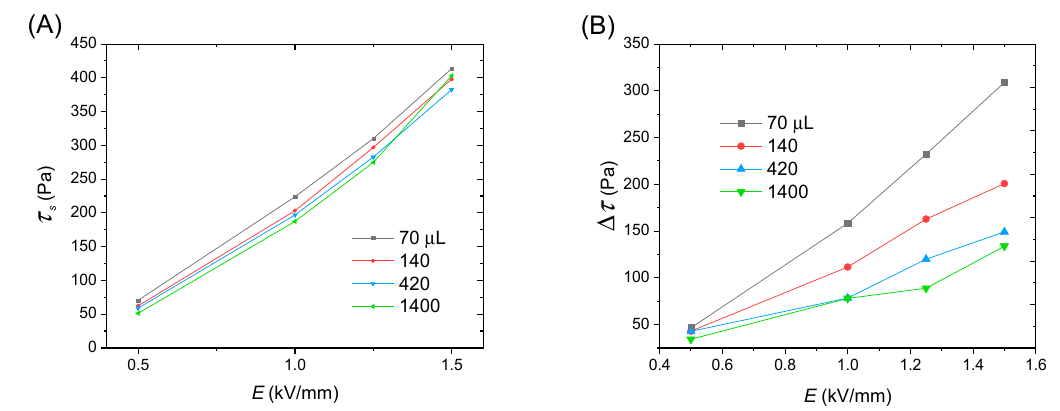
Figure 7. Electric field dependence of static yield stress ( A ) and shear stress difference with and without electric fields at 60 s − 1 ( B ) for ERFs of PEANI/rGO obtained by reduction with different amounts of hydrazine ( T = 25 °C).